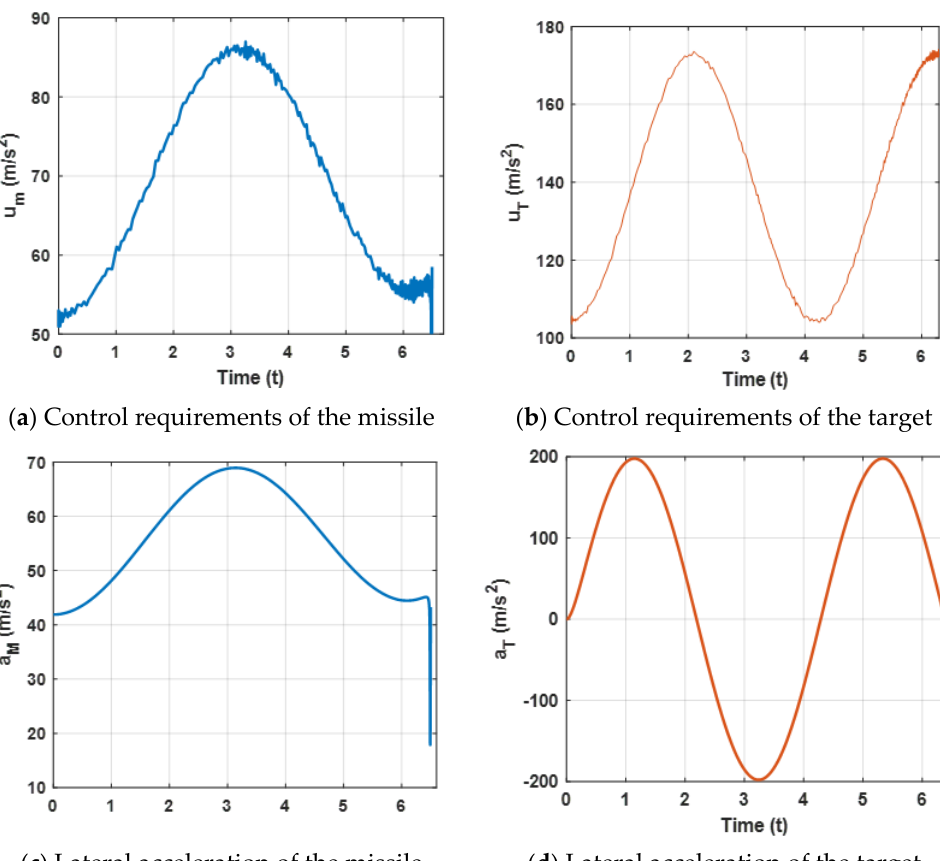
Figure 11. Acceleration demands of the missile and the target.